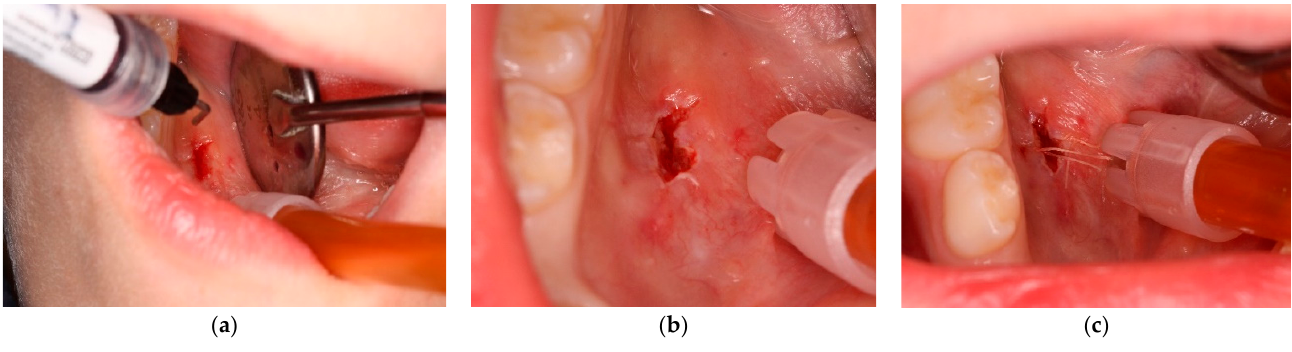
Figure 5. This figure shows modified sclerotherapy using Hybenx ® gel (attempt n ◦ 3). ( a ) Hybenx ® gel is injected into the lumen of the lesion; ( b ) 20 s after application, Hybenx ® gel is aspirated, and the area is rinsed with saline solution; ( c ) the margins of the lesion are sutured. The procedure was as